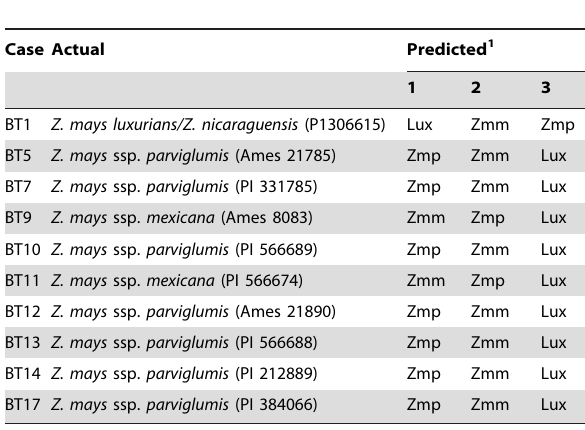
Table 3. Two-variable (A-1-B-3/3, A-1-B-1/1) MDA classification matrix of BT assemblages (direct method).